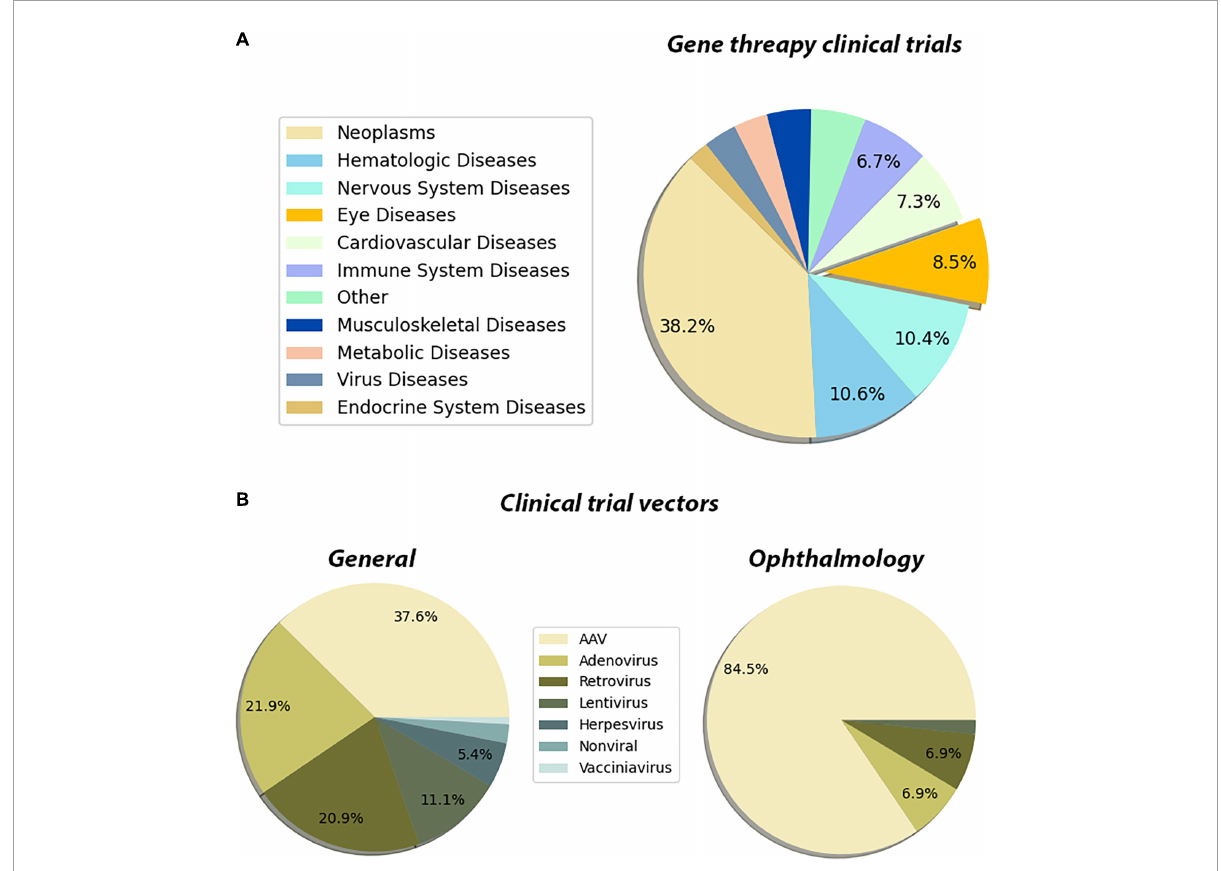
FIGURE3 Pie chart distribution of disease categories and vectors used in gene therapy clinical trials. (A) The distribution of the disease categories targeted by the clinical trials that are using gene therapy methods. The metadata of the gene therapy trials has been downloaded from the ClinicalTrials database. The Medical Subject Headings (MeSH) thesaurus has been produced by the National Library of Medicine and serves as a hierarchically organized vocabulary for indexing, cataloging, and searching for biomedical and health-related information (Dhammi and Kumar, 2014). In the tree structure of the MeSH thesaurus, each term has a code indicating the parent groups of the term. By using the “Diseases” categories in the MeSH tree, the clinical trials have been assigned to one of the categories. The assignments have been made by matching the MeSH terms registered in the clinical trial’s entry, with the disease category in the MeSH tree. For entries that have been registered to multiple disease categories, a priority list has been created manually. These clinical trials have been assigned to the disease type which has a higher priority in the created list. The subcategories of the eye diseases have been retrieved from the MeSH terms section of the trial’s page and the bar graph showing the distribution of such subcategories has been plotted. The entries which are associated with multiple subcategories have been assigned to the term which has a higher priority in the created list. (B) The distribution of the vectors used in the gene therapy clinical trial. A list of keywords for the vectors that have been used in the gene therapy methods has been created. By using the API (Application Programming Interface) of ClinicalTrials.gov, each keyword has been searched along with the “gene therapy” keyword. In these search operations, the database searches the given terms with their synonymous representations. Through the search operations, the distribution of vectors that have been used in clinical trials has been retrieved. Then the same search has been repeated by adding the keyword “eye diseases.” Through this search operation, the distribution of the used vectors in the gene therapy clinical trials targeting eye diseases has been retrieved. The whole data processing and plotting procedure have been automatized by a custom Python script. Data is registered on ClinicalTrials.gov as of